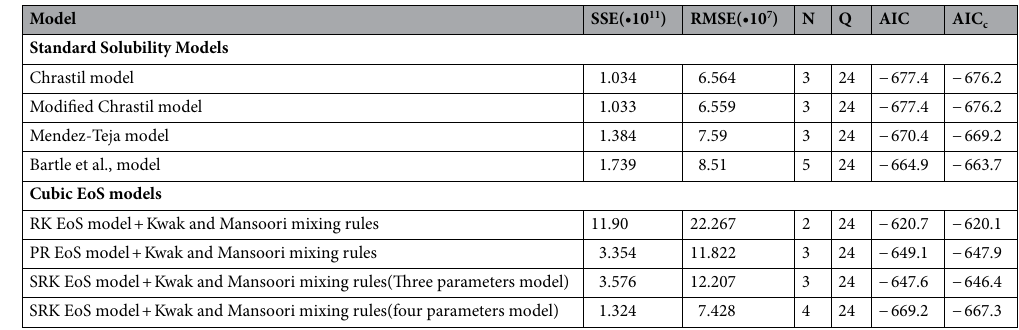
Table 8. Models and their statistical